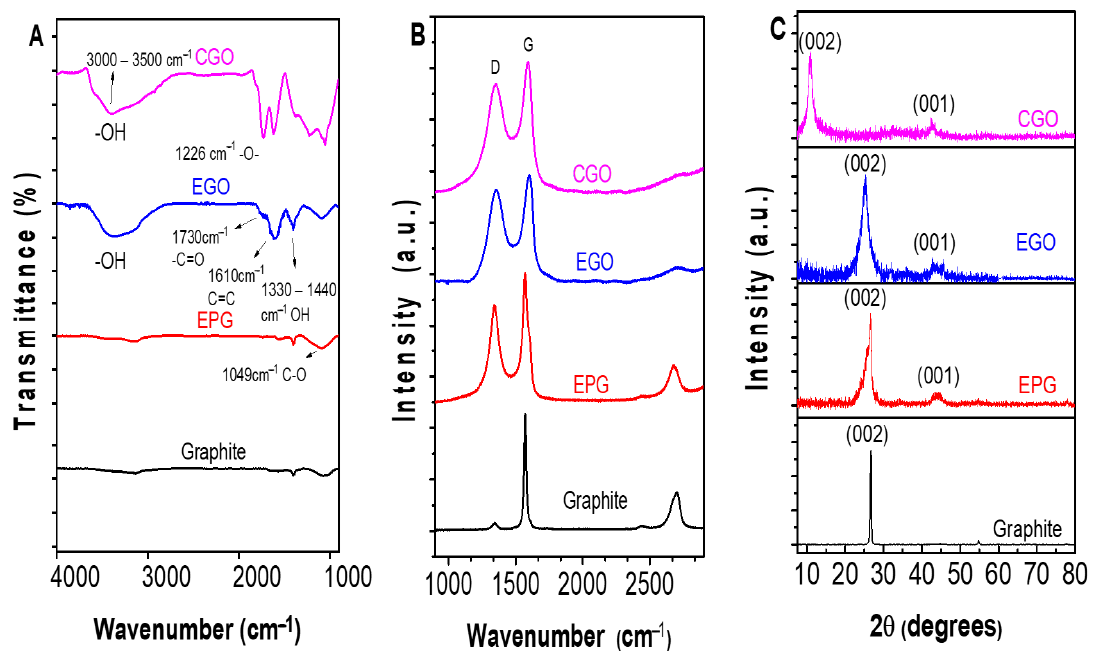
Figure 3. ( A ) Fourier Transform Infrared (FT-IR) spectra of graphite, ( B ) Raman spectra and ( C ) X-ray Diffraction (XRD) spectra of graphite, EPG, EGO, and CGO.